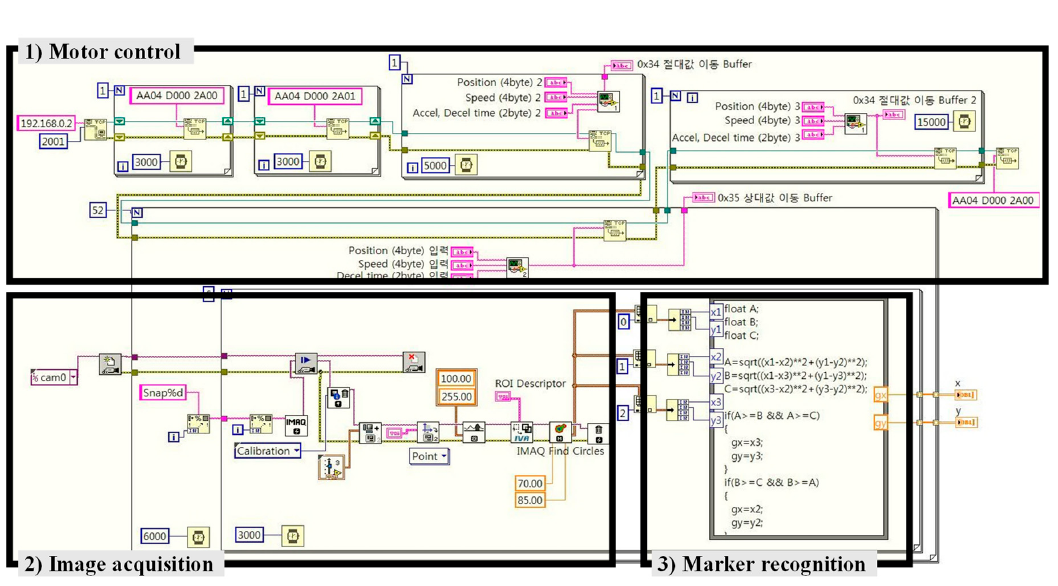
Figure 13. LabVIEW code for the look-then-move process.